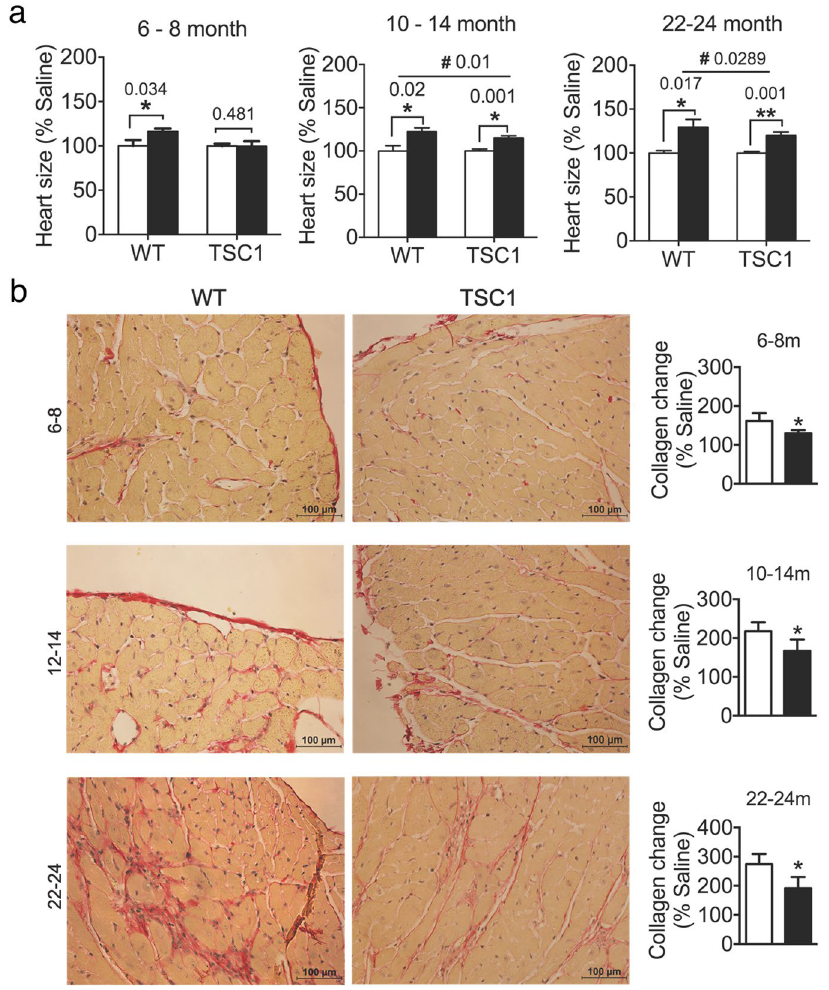
Figure 7. Cardiac function analysis after isoproterenol injection. ( a ) Heart size (ratio to body weight) in young (6–8 month, n = 8 for each group), middle aged (10–14 months, n = 8 WT, n = 12 TSC1 tg ), and old (22–24 months, n = 13 WT, n = 15 TSC1 tg ) female mice before and after isoproterenol challenge. White bar – mice with saline; black bar – mice with isoproterenol injection. Asterisks ( * p < 0.05 and ** p < 0.01) indicate statistical significance between isoproterenol injected mice and saline injected mice. Ampersand ( # p < 0.05) indicates statistical significance in the degree of hypertrophy after isoproterenol injection between Tsc1 tg mice and wild type mice. ( b ) Histological examination of left cardiac tissue from young (6–8 month), middle aged (12–14 month), and old (22–24 month) female mice using Picrosirius Red Staining as described in the method section (n = 6 mice in each group). Collagen content changes during hypertrophy were calculated as a percentage of collagen content after isoproterenol against saline injected mice of the same genotype. Asterisks ( * p < 0.05) indicate statistical significance between Tsc1 tg mice and wild type